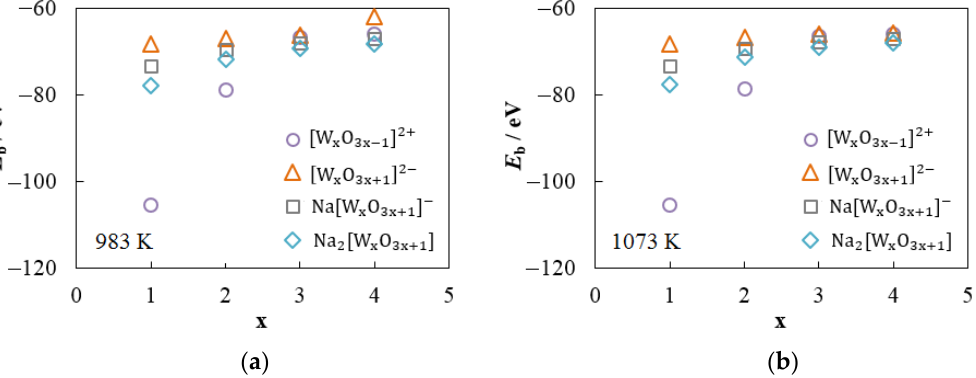
Figure 6. Dependences of W–O bond energy on the number of W atoms in the compound at ( a ) 983 K and ( b ) 1073 K.